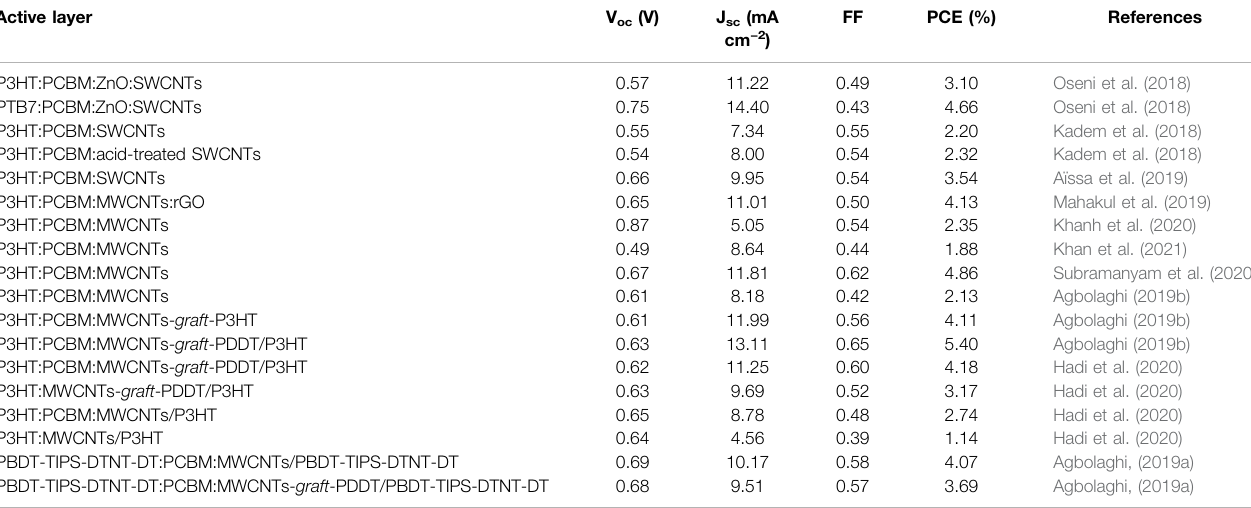
TABLE 2 | Photovoltaic parameters of OSCs employing CNT-based active layers. Active layer V oc (V) J sc (mA